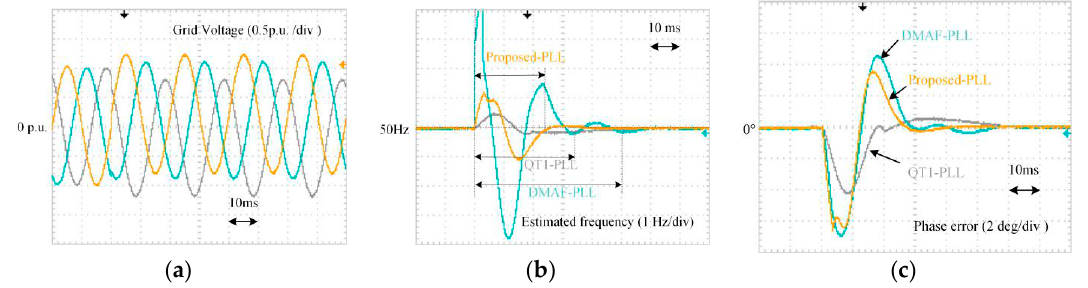
Figure 26. Experimental waveforms under a dc offset injection condition: ( a ) Three-phase voltages; ( b ) Estimated frequency; ( c ) Phase error.